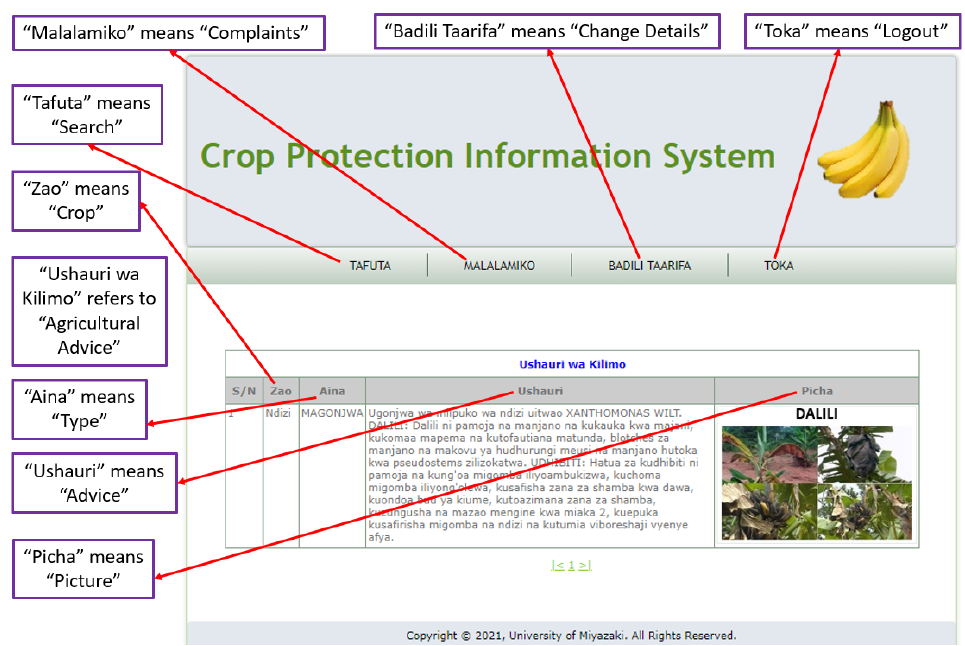
Figure 7. Banana crop protection information (symptoms and control measures of banana Xan- thomonas wilt) with elaboration picture (visual symptoms) in the Web